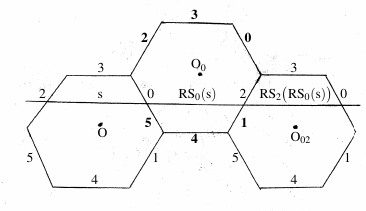
meets the edge 0, isreflected in 1,1,1